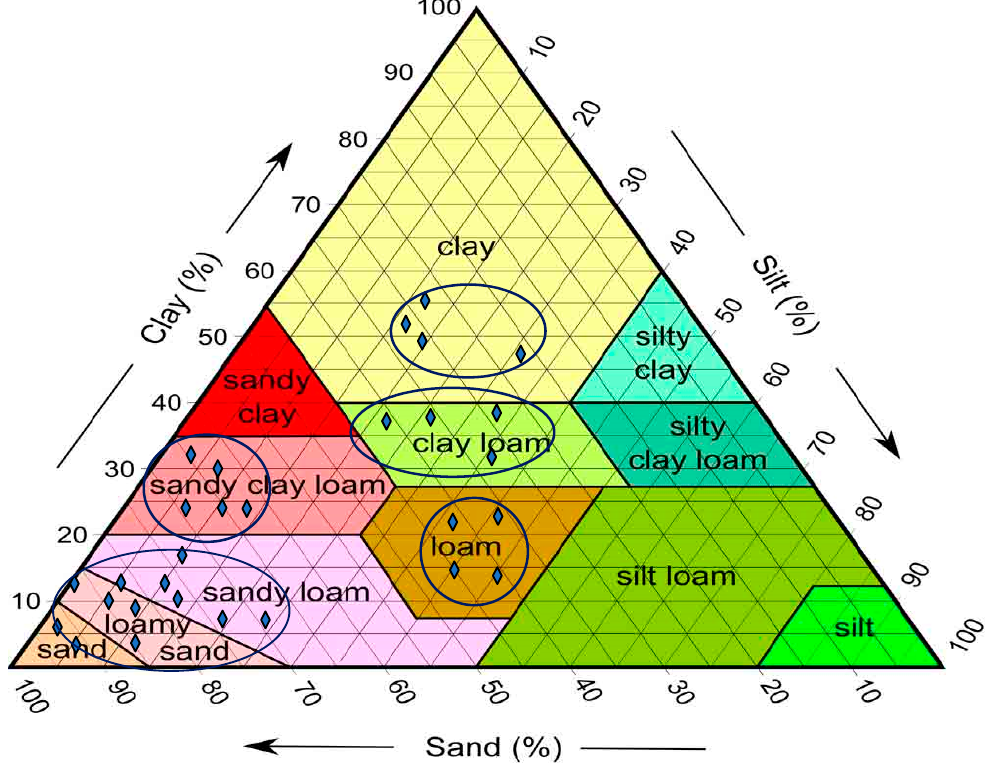
Figure 4. Textures found in the soils of the Tablas de Daimiel National Park (TDNP) flood zone. − 1 − 1 13.50 and 274.93 g · kg (average 66.03 g · kg ), while the Al concentration is between 2.12 and − 1 − 1 48.05 g · kg (average 12.86 g · kg ). The Fe concentration ranges between 0.91 g · kg